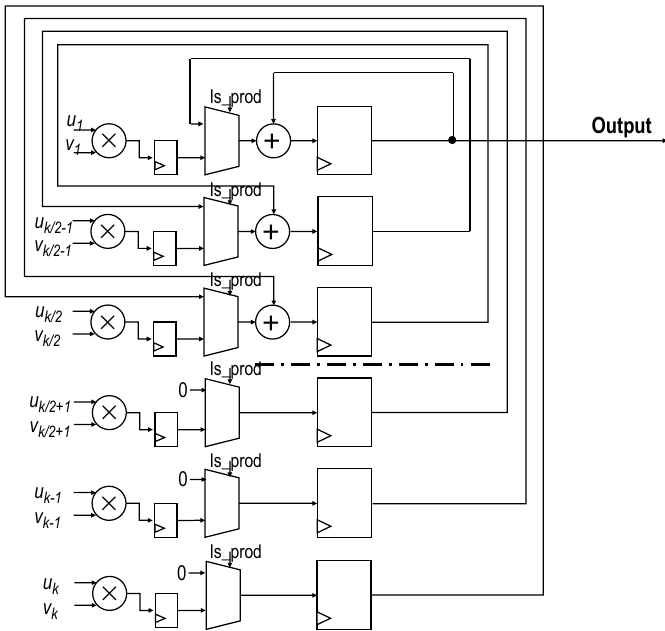
Figure 9. Scheme of proposed sum of product architecture that substitutes traditional tree-adder